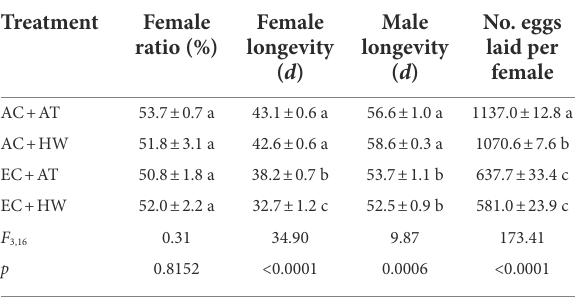
grown under different treatment